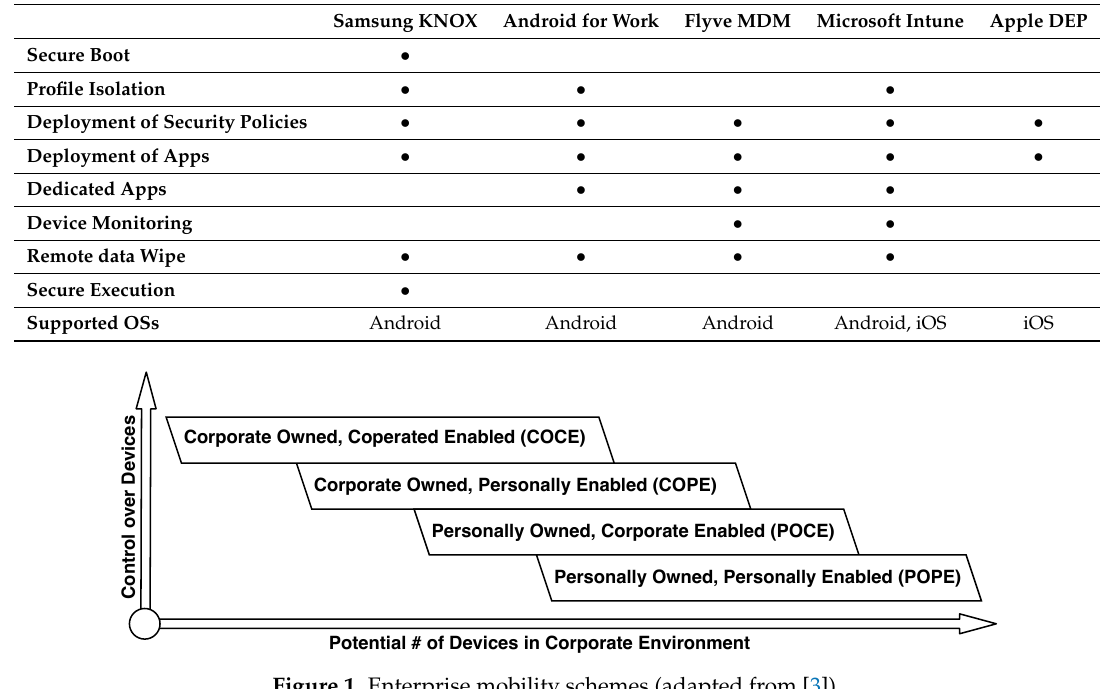
Figure 1. Enterprise mobility schemes (adapted from [3]).